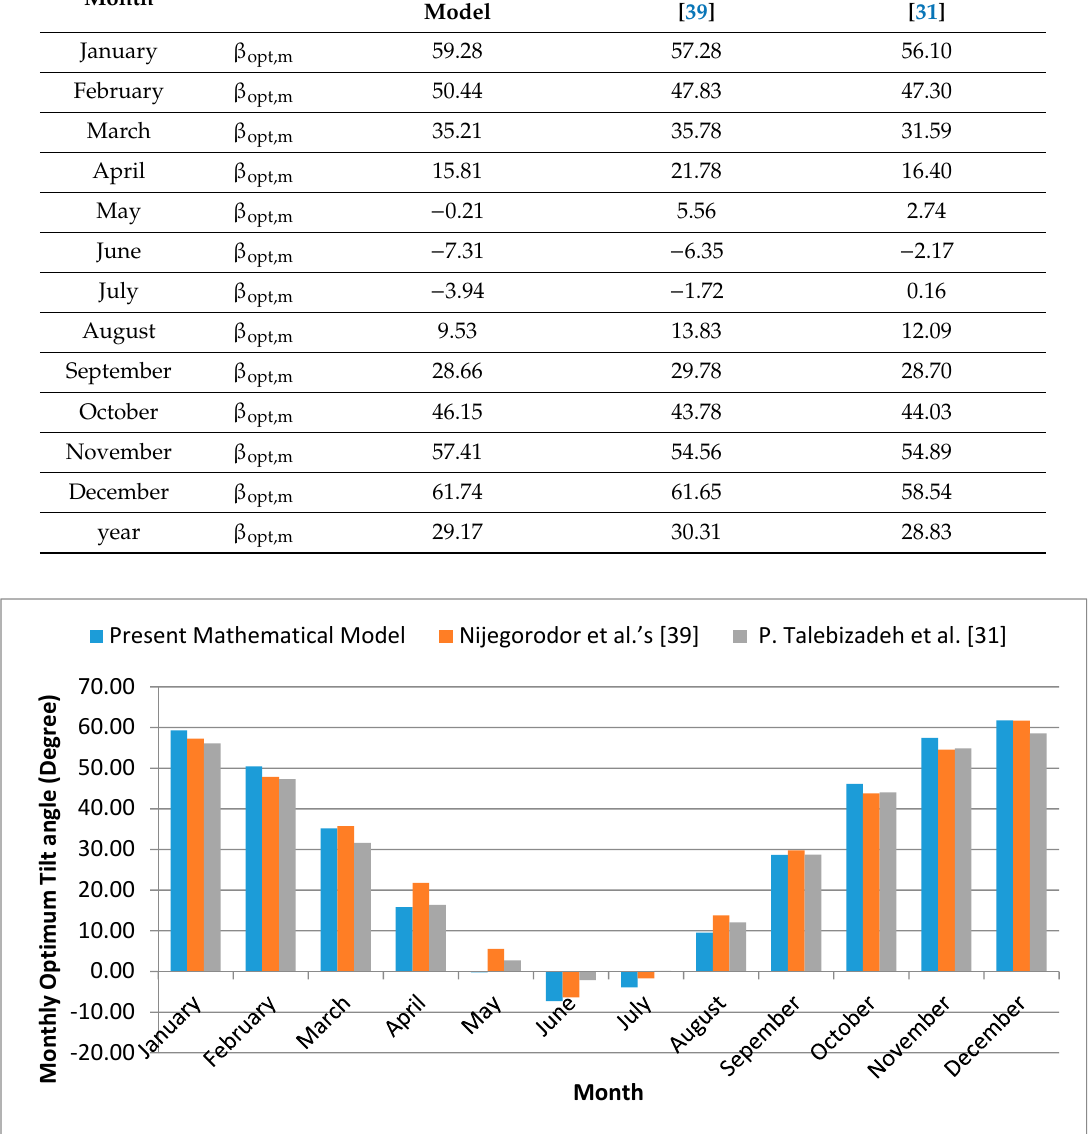
Table 19. A comparison of monthly and yearly tilt angles for Jerusalem based on Nijegorodor et al. and P. Talebizadeh et al. with the values calculated in the present mathematical model.